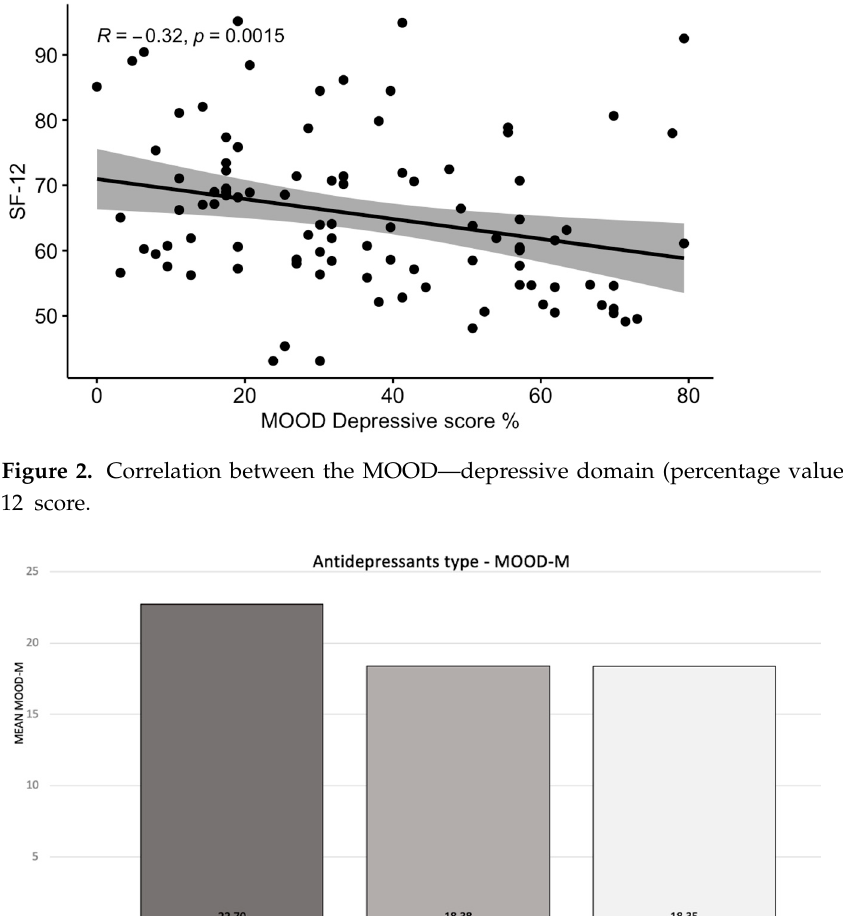
Figure 1. Correlation between the MOOD—depressive domain (percentage values) and the FIQ score.